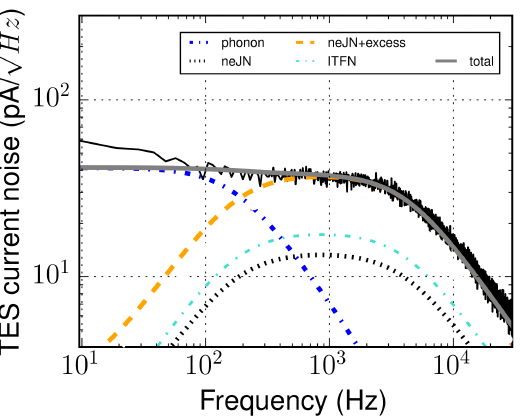
Figure 6. Current noise spectra of a Ti/Au 80 × 40 µ m 2 TES X-ray calorimeter developed at SRON, biased at 2.5MHz, at R / R n ∼ 0.2 with α ∼ 370 and β ∼ 5